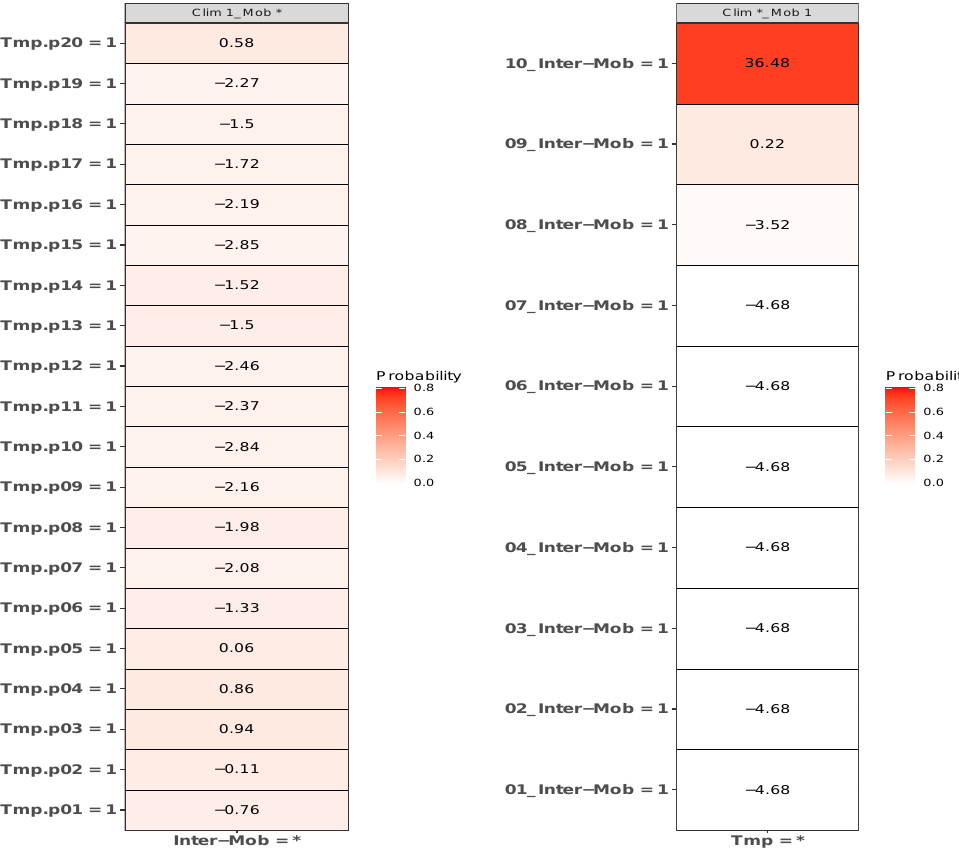
= 1 ) for each value of X n j | = Internal labour flow of the j